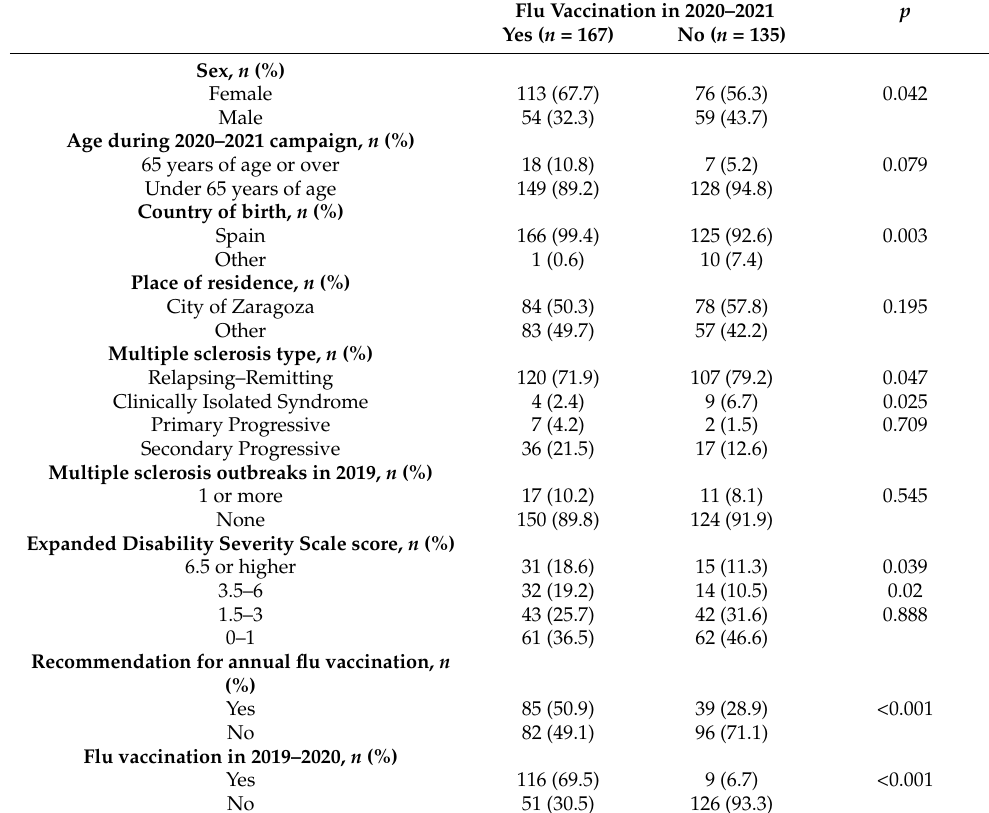
Table 3. Results of bivariate